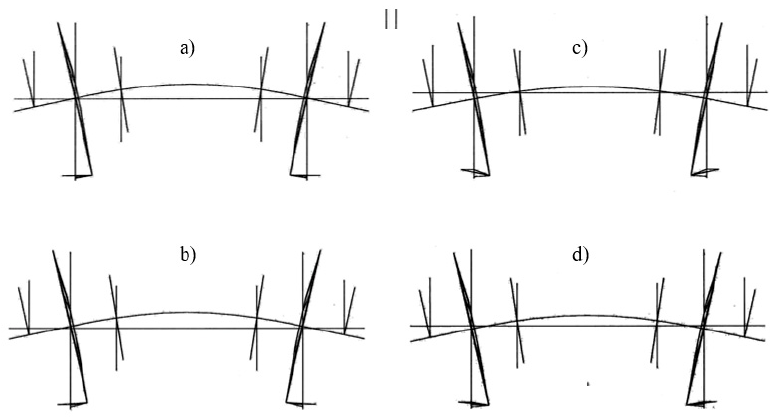
Figure 10. Calculated elastic mode of a wheelset on different track stiffnesses ( a ) k = 50 × 10 8 N/m at 66.8 Hz, ( b ) k = 10 × 10 8 N/m at 65.4 Hz, ( c ) k = 2.5 × 10 8 N/m at 77.3 Hz, ( d ) k = 0.5 × 10 8 N/m at 71.8 Hz.